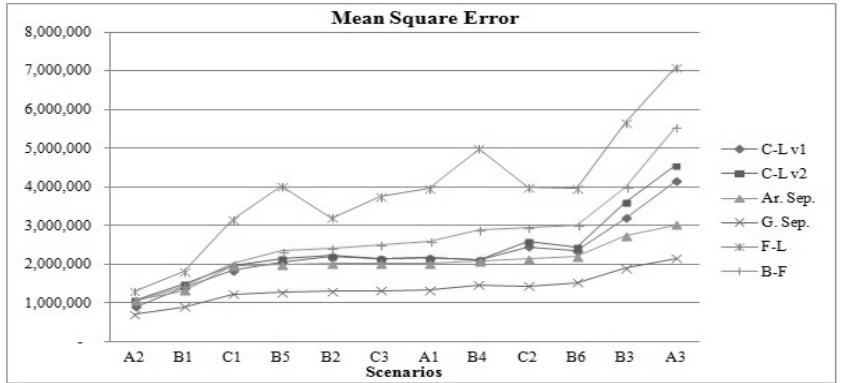
Fig. 2. Mean square error of the estimators by varying the temporal distribution of the number of settlements